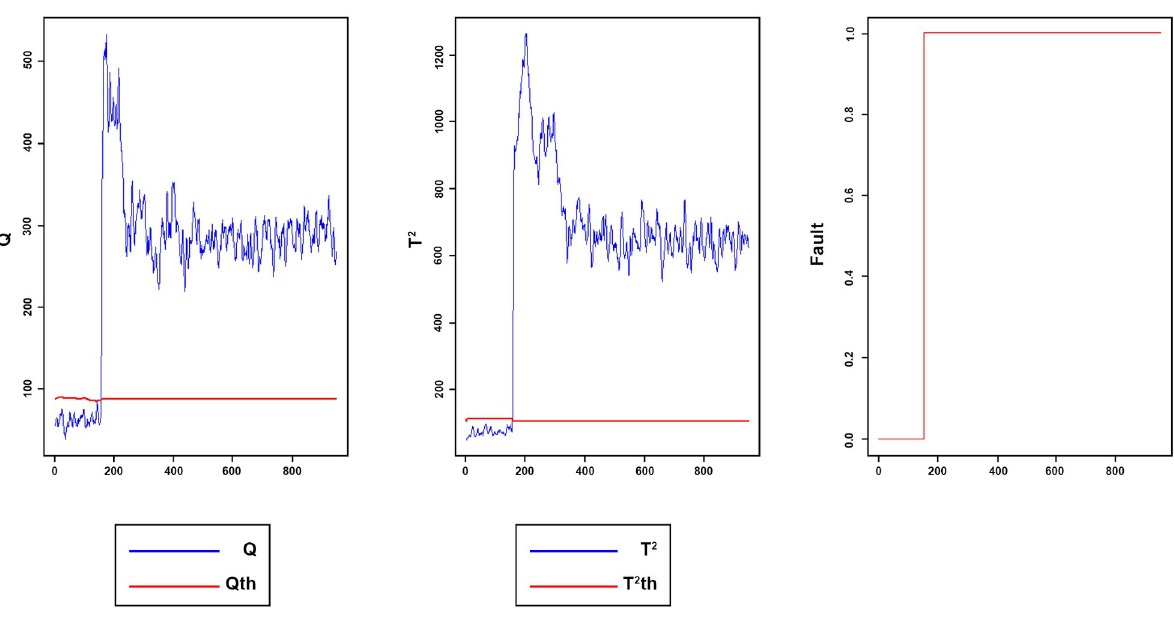
Fig 9. Monitoring performance of MWDPCA for fault 7.